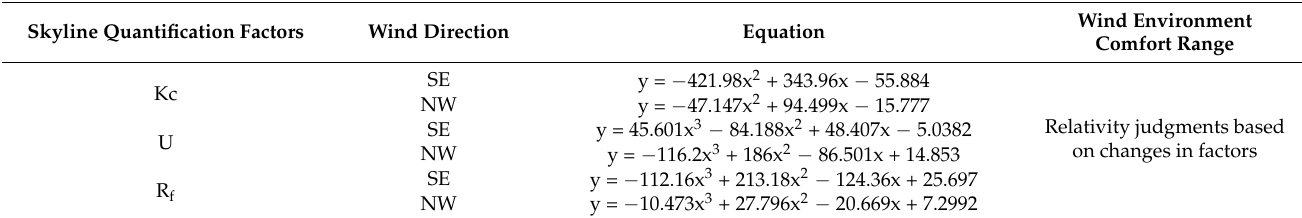
Table 20. The relationships between skyline quantification factors and wind speed